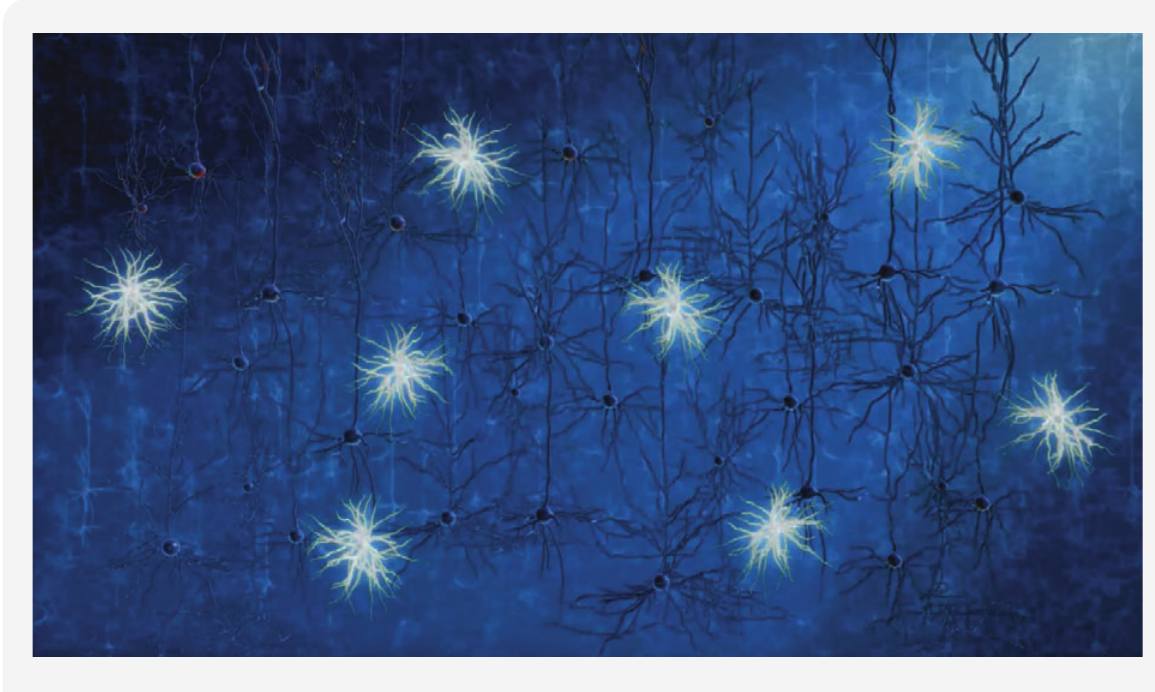
Figure 6. Cartoon of a neural network with the parvalbumin-positive interneurons expressing channelrhodopsin-2. Exposing the brain circuit to blue light causes the parvalbumin-positive interneurons to fi